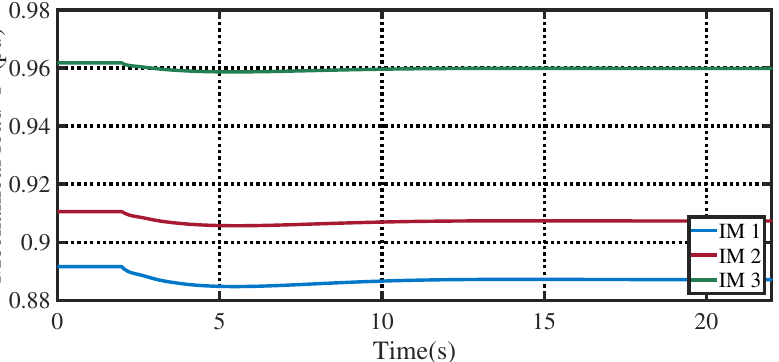
Figure 11. Induction motors’ mechanical load dynamics in the modified IEEE 9-bus system during the under-frequency